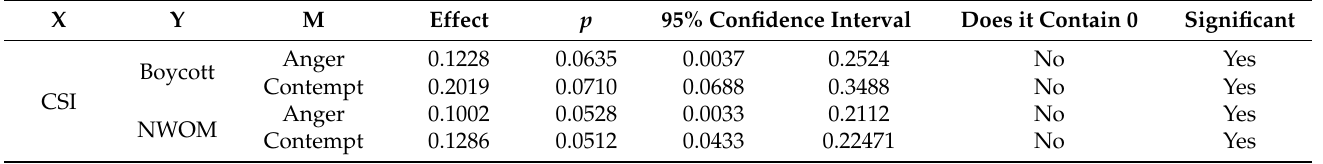
Table 6. The mediating role of negative emotions in terms of CSI and consumer response.